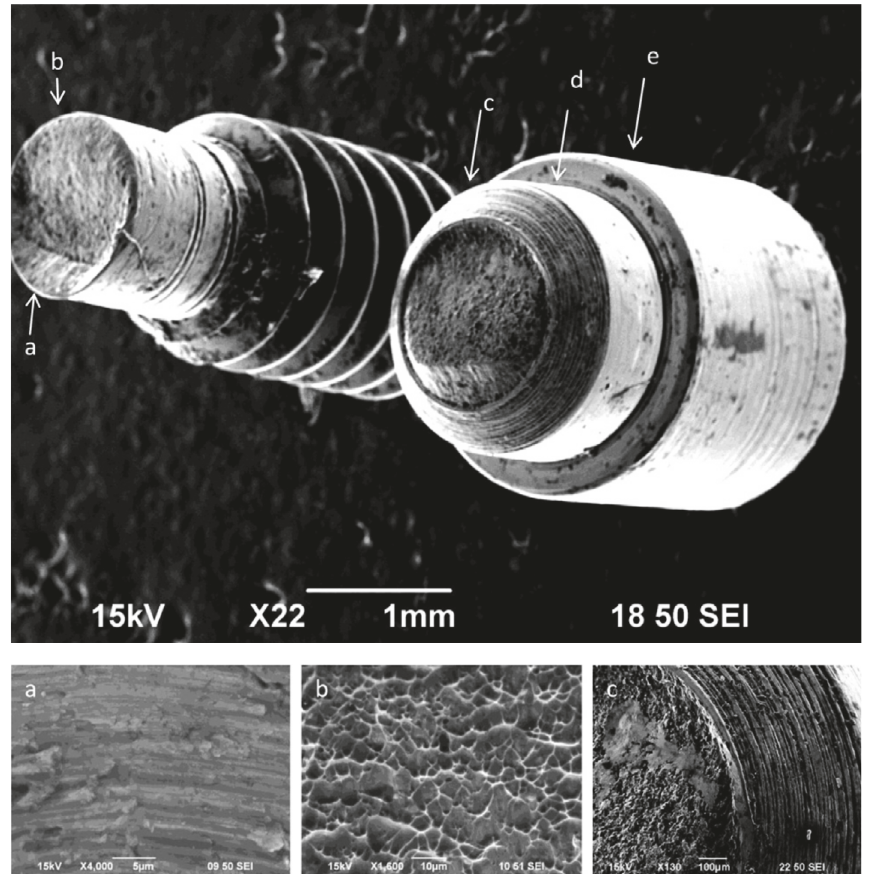
Figure 9: SEM images depicting different regions of the fractured dental implant surface. Copyright @Elsevier, reproduced with permission from Elsevier